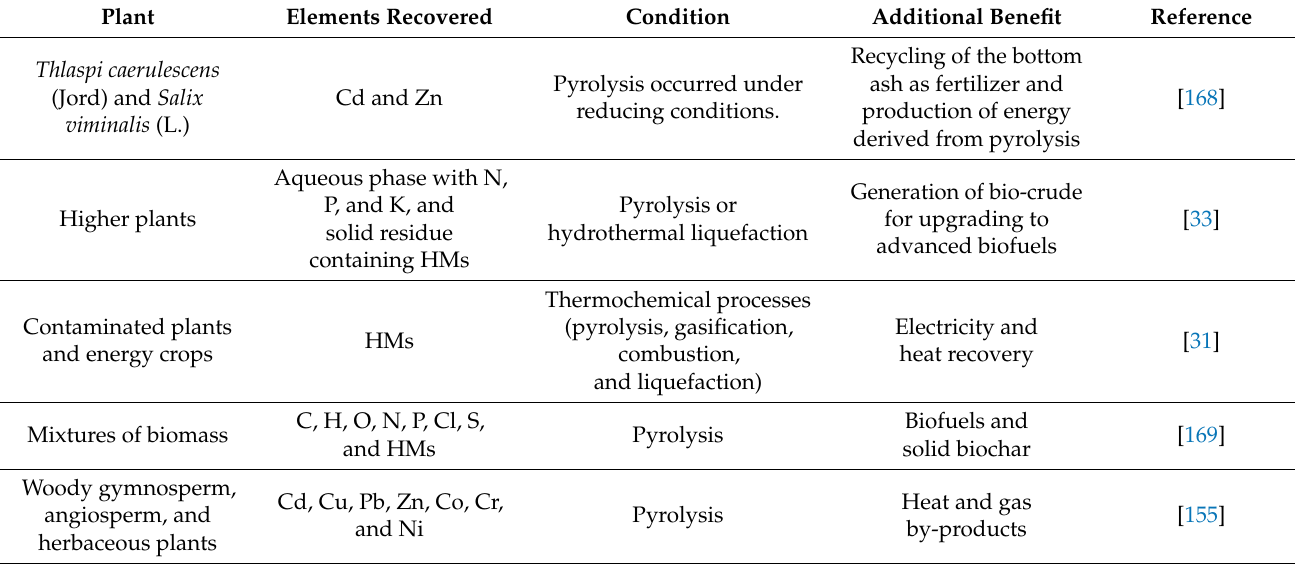
Table 6. Viable and feasible options for the treatment of potential toxic-metal-enriched plants produced by phytoremediation. Plant Elements